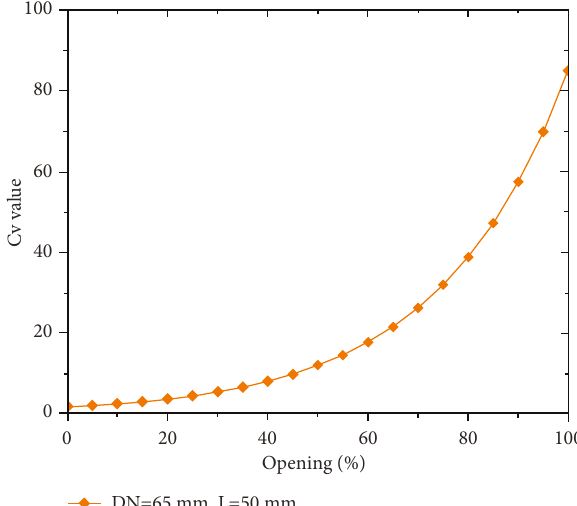
Figure 5: Control valve flow characteristic